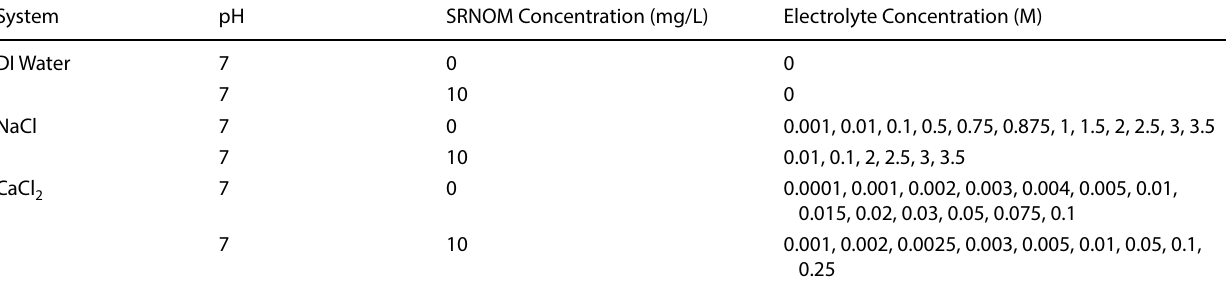
include diH2O, two types of electrolytes — monovalent cation Na + at concentrations ranging from 0.001 to 3.5 M, and divalent cation Ca 2+ at concentrations ranging from 0.0001 to 0.25 M at pH 7 — and in both the absence and presence of SRNOM at 10